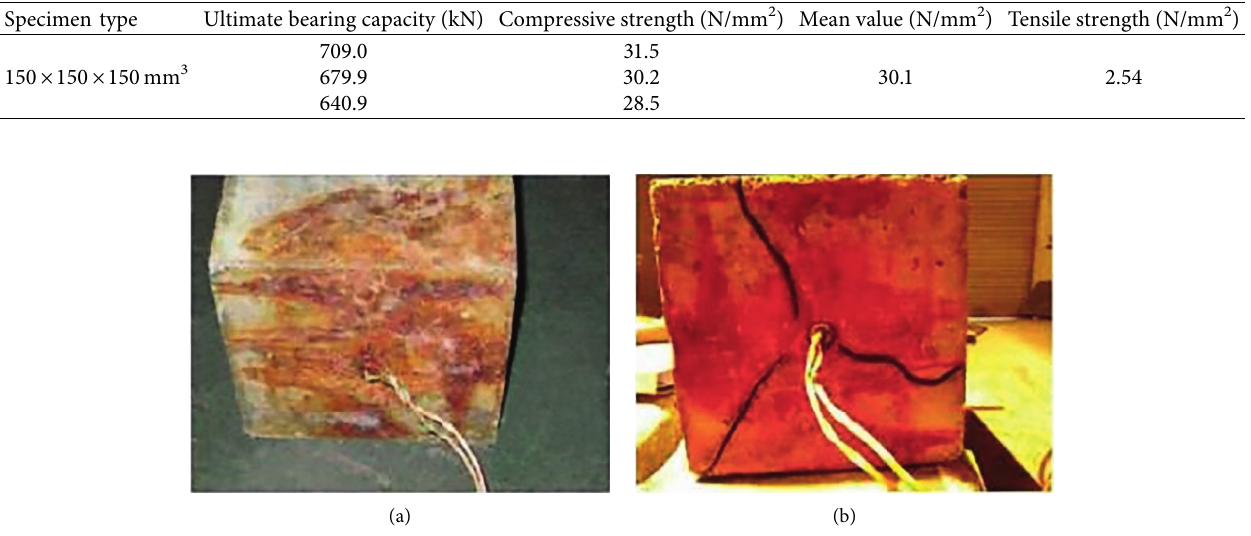
Figure 5: Corrosion expansion cracks of specimens. (a) Corrosion rate η � 3.6%. (b) Corrosion rate η � 4.5%.